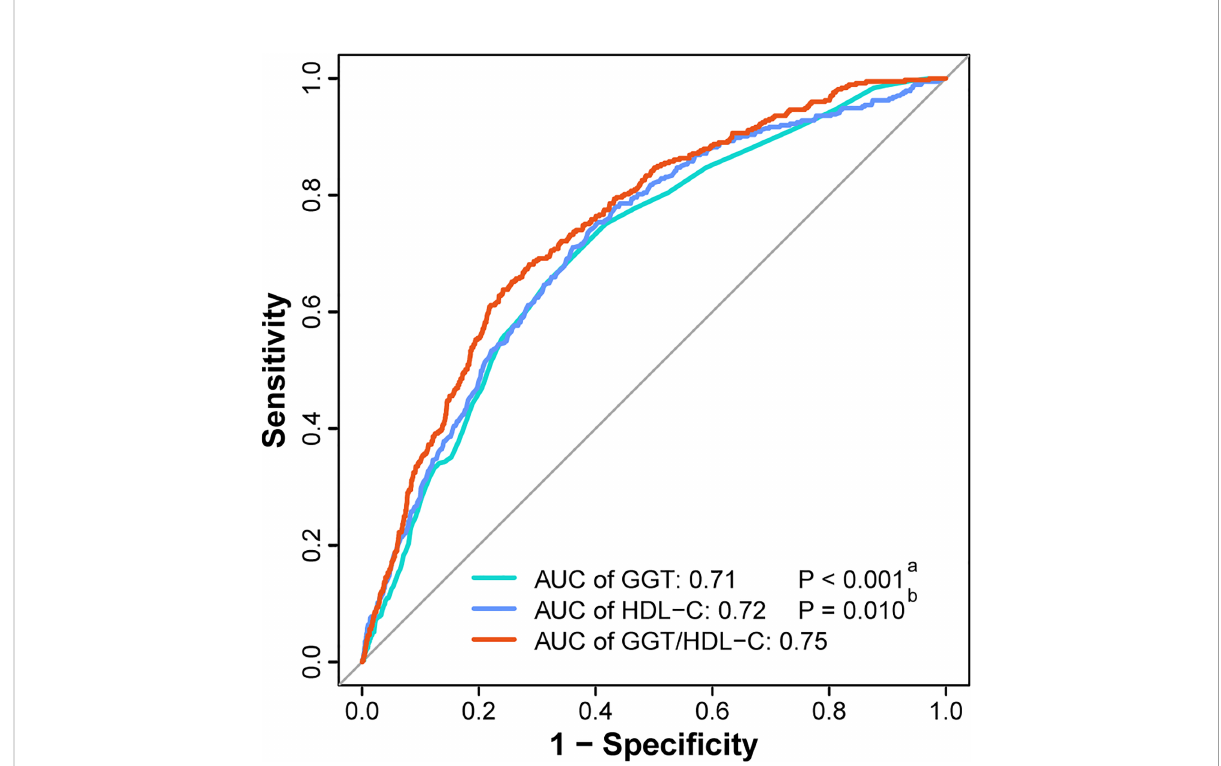
FIGURE 4 ROC curves of GGT, HDL-C and GGT/HDL-C ratio to predict incident T2DM. ( a ) The P value of GGT compared with GGT/HDL-C ratio. ( b ) The P value of HDL-C compared with GGT/HDL-C ratio. AUC, area under the curve; GGT, gamma-glutamyl transferase; HDL-C, high-density lipoprotein cholesterol; ROC curve, receiver-operating-characteristic curve; T2DM, type 2 diabetes